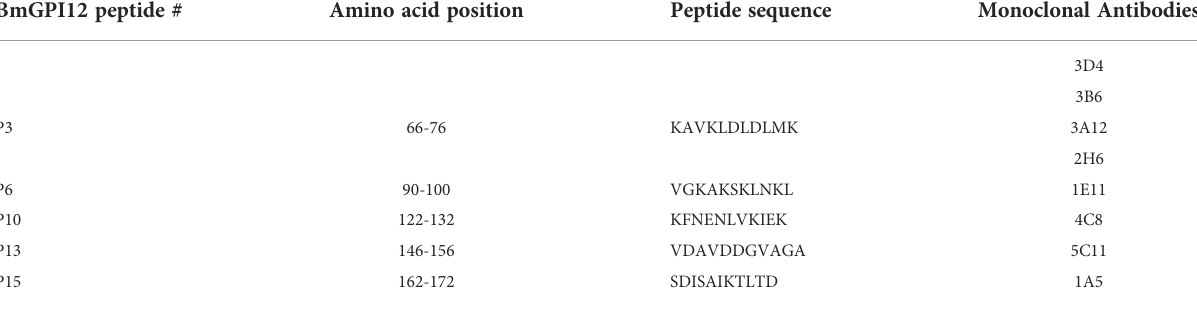
TABLE 3 Primary sequences of the 5 BmGPI12 peptides recognized by a set of monospeci fi c monoclonal antibodies. BmGPI12 peptide